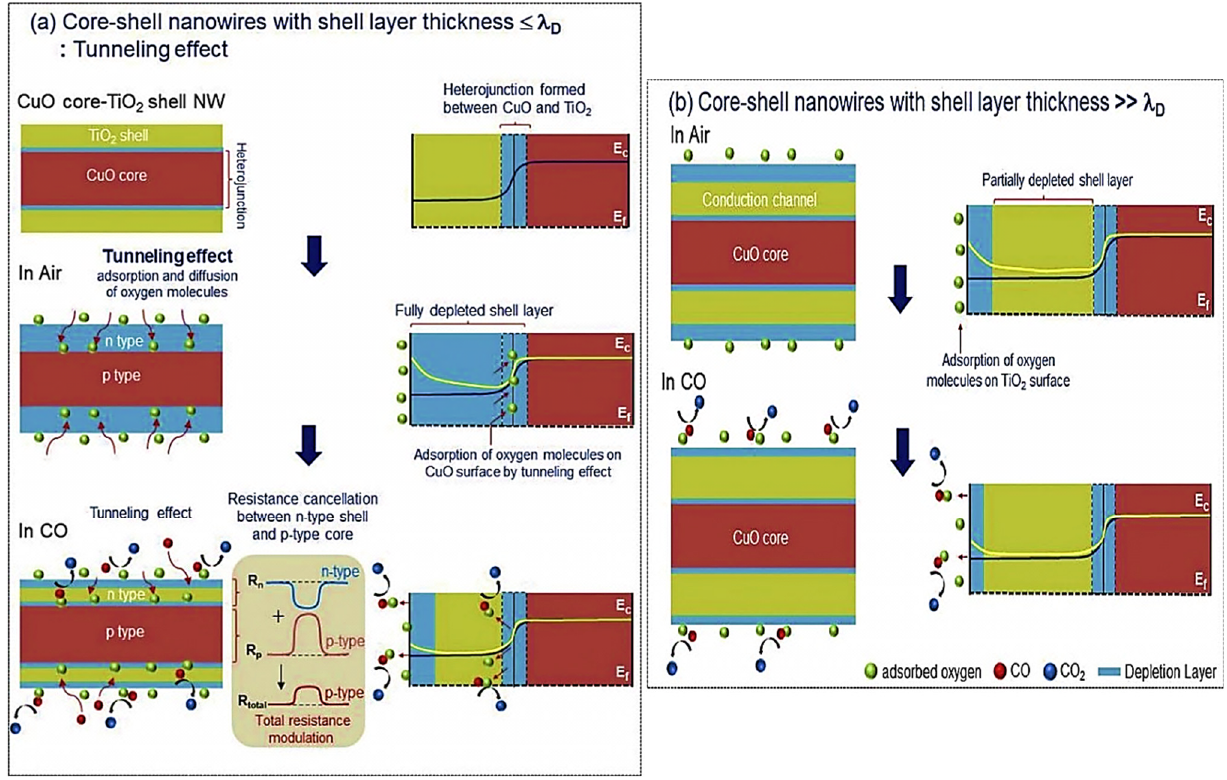
Figure 9. Schematic of the detection mechanism of CuO-TiO 2 C-S NWs with the shell layer thickness of ( a ) < λ D and ( b ) > λ D [80]. Reproduced from [34] with the permission of Elsevier. Katoch et al. [81] synthesized p- CuO/ n -ZnO C-S NFs for CO gas-sensing applications.